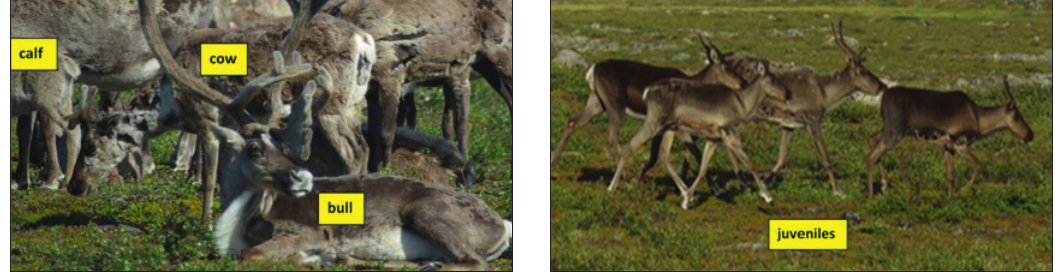
Fig. 8. Differential timing of hair moult among caribou during July (Photo, Leslie Table 3. Temperature, precipitation and cumulative oestrid (adult warble & bot fly) index for the period 15 June to 15 August 2007 for Akia-Maniitsoq and 2008 for Kangerlussuaq-Sisimiut.